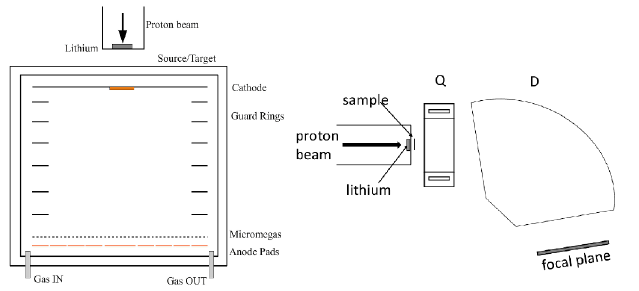
Figure 1. (Left) Schematic of conceptual experimental set-up for Phase-I experiments, and micromegas based gaseous detector. (Right) Schematic of conceptual experimental set-up for Phase-II experiments, and large angle spectrometer.